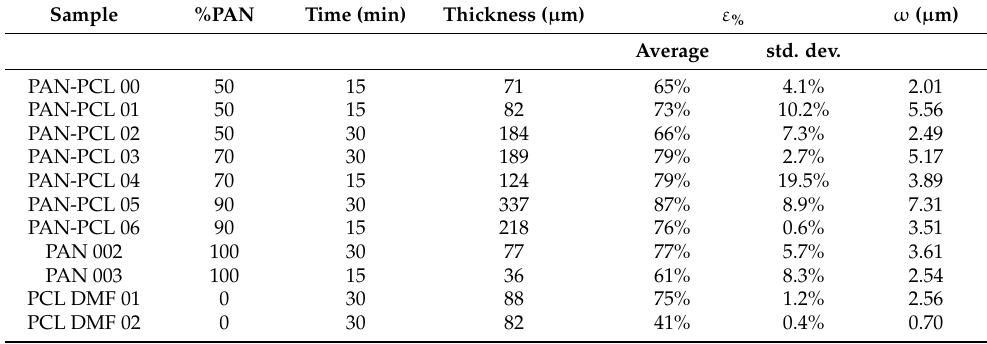
Table 8. Measured percent porosity and estimated average pore radius for all samples.